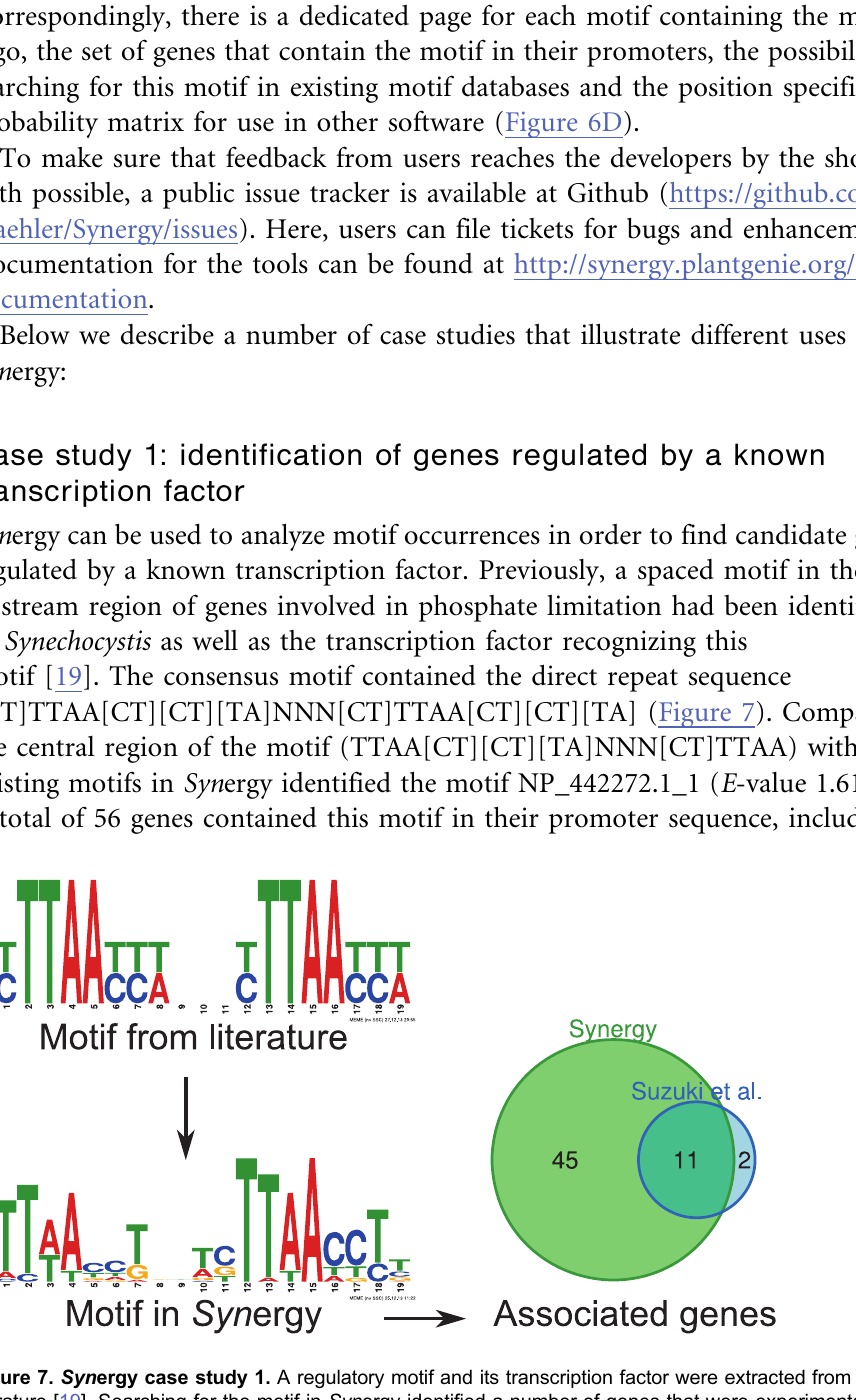
Figure 7. Syn ergy case study 1. A regulatory motif and its transcription factor were extracted from the literature [19]. Searching for the motif in Syn ergy identified a number of genes that were experimentally determined to be regulated by this transcription